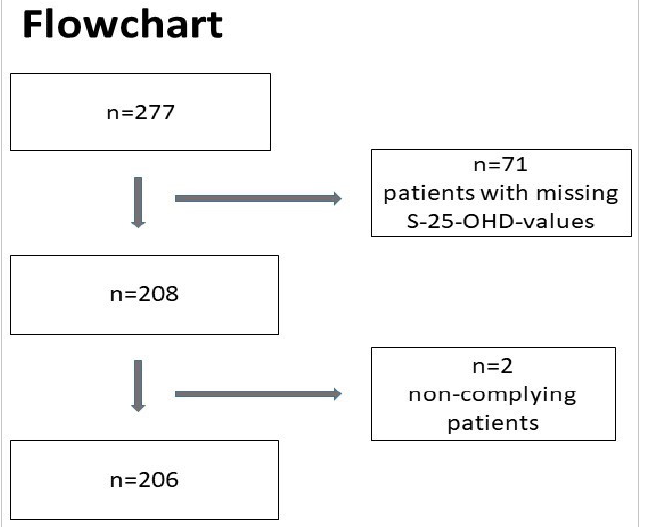
Figure 2. Figure 2. Flowchart.